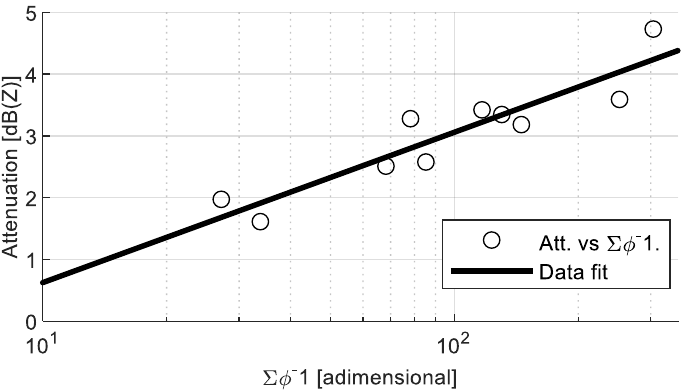
Figure 15. Correlation between acoustic attenuation and the logarithm of the sum of the inverse of porosity (R 2 = 0.8).